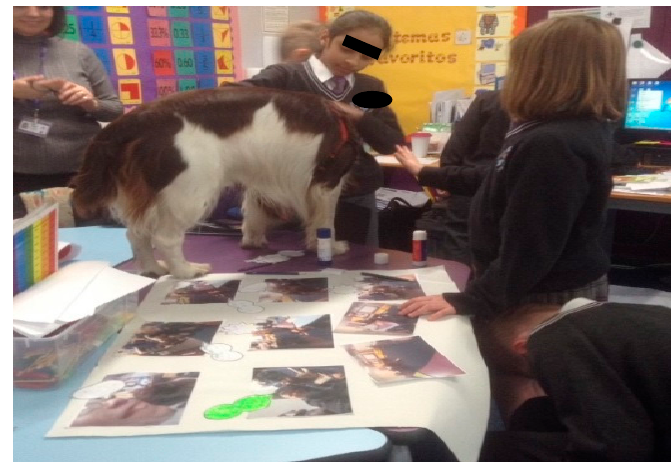
Figure 10. Making comic panels with Ted, telling a story with visual-material methods.